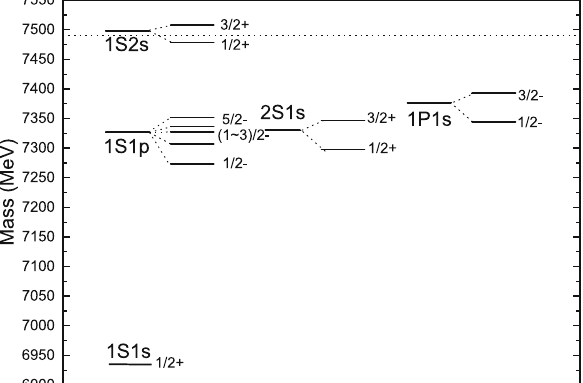
Fig. 3 Mass spectrum (in MeV) of the (cid:2) bc baryons, corresponding to the Table 12. The horizontal dashed line shows the (cid:4) b D threshold